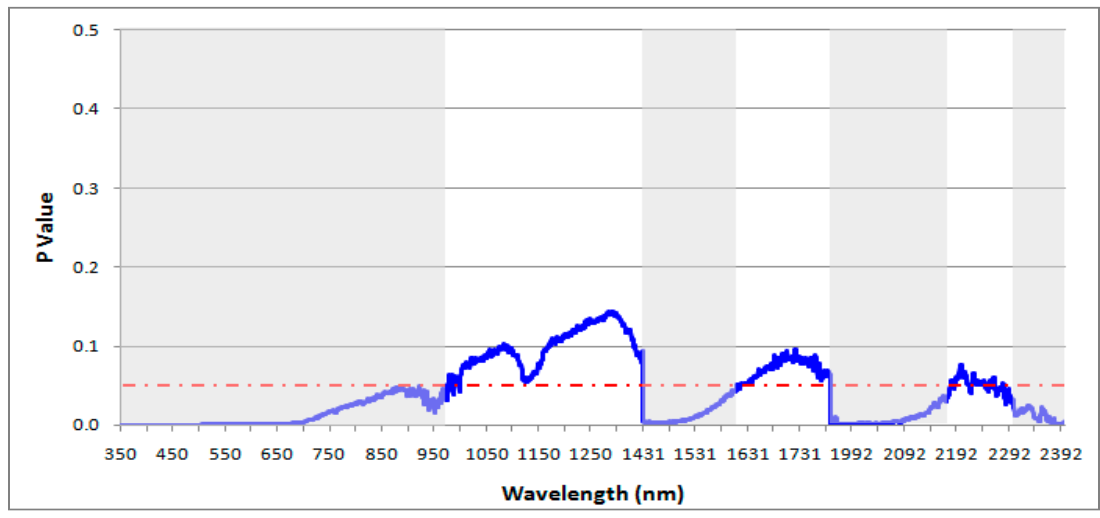
Figure 8. Wavelength-intervals shaded grey depict statistically significant differences between the field-based spectra. The red-dashed line denotes the limit for statistical significance (95% confidence level).